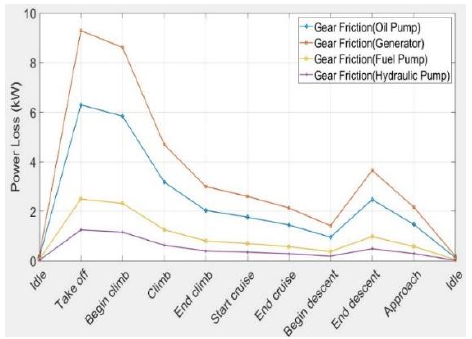
Figure 3. Power losses due to gear friction.